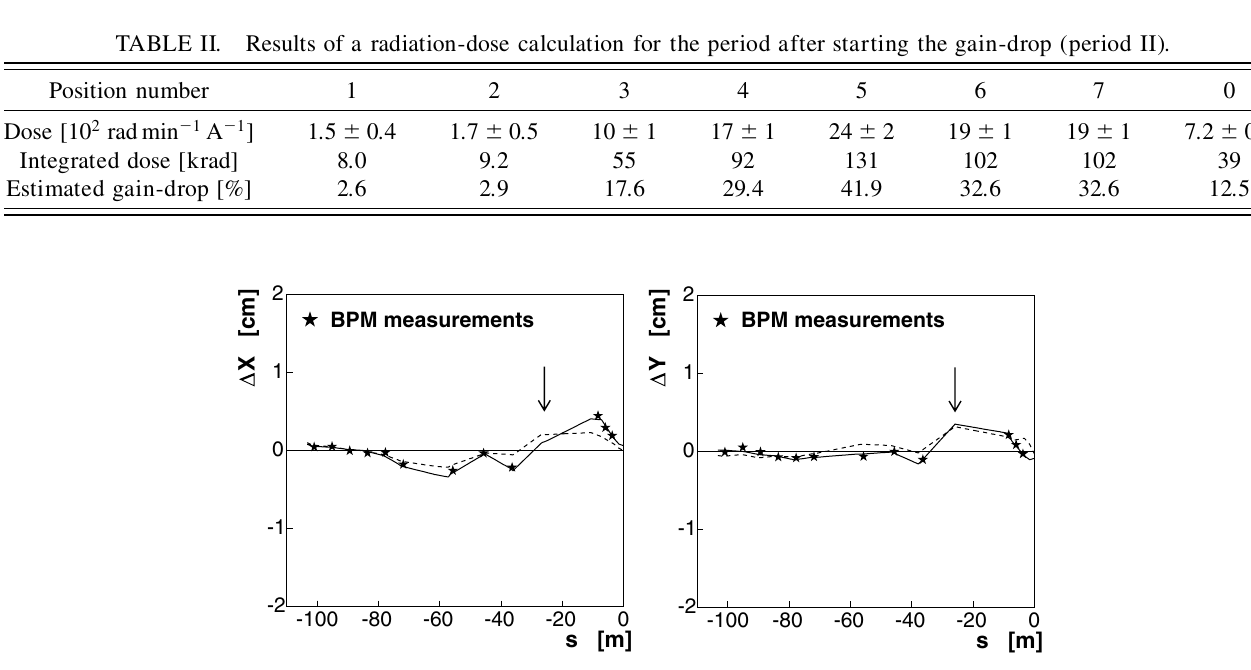
FIG. 6. Fitted beam orbits around the SVD gain-drop accident. The dotted line indicates the orbit in period I and the solid line in period II. The vertical arrow points to the BEND which made a dominant contribution to the SVD gain-drop in period